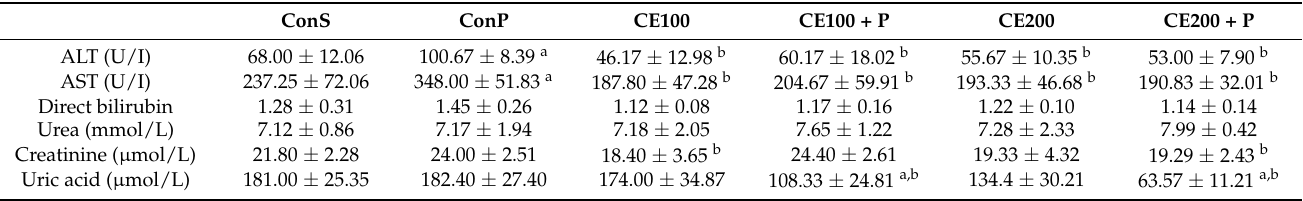
Table 5. Serum activity of alanine aminotransferase (ALT); aspartate aminotransferase (AST); direct bilirubin level; urea; creatinine; and uric acid (mean ± SD; n = 7) in animals treated with saline and carob